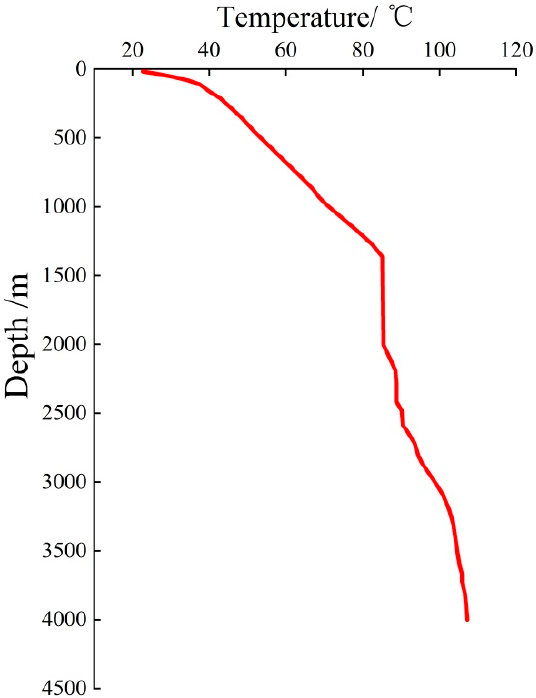
Figure 12. Temperature measurement curve of borehole GRY1.